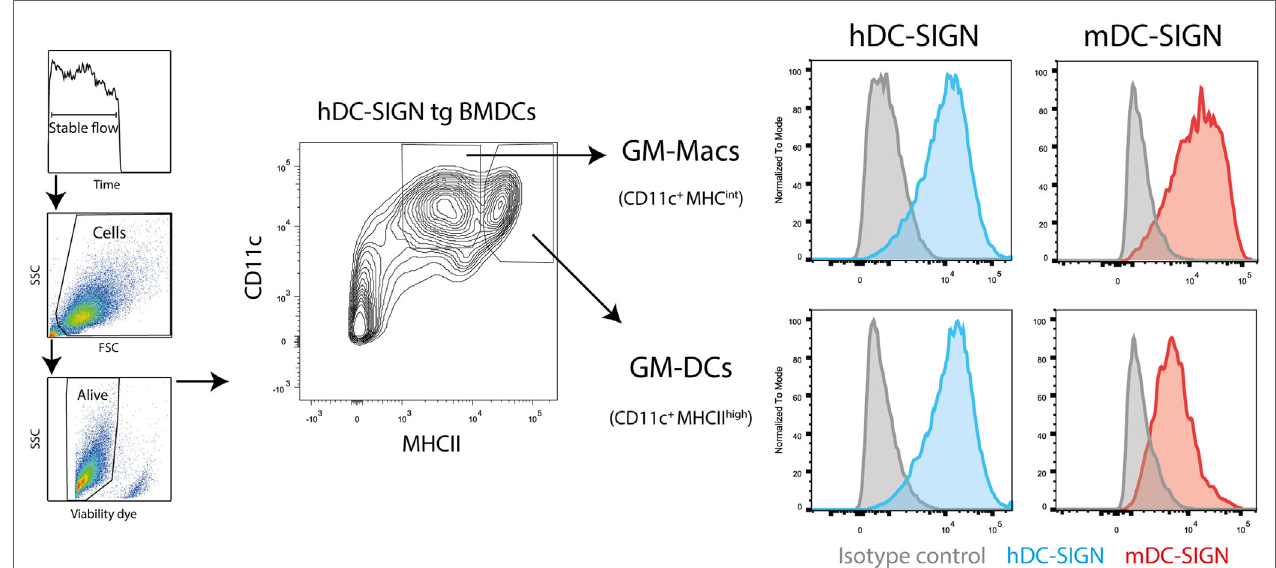
FigUre 1 | Mouse dendritic cell-specific intercellular adhesion molecule-3 grabbing non-integrin is expressed by GM-DCs and GM-Macs cultured in vitro cultures. Both GM-CSF-cultured (differentiation for 7 days) bone marrow-derived macrophages (GM-Macs) and dendritic cells (GM-DCs) express mDC-SIGN. Data are representative of two individual